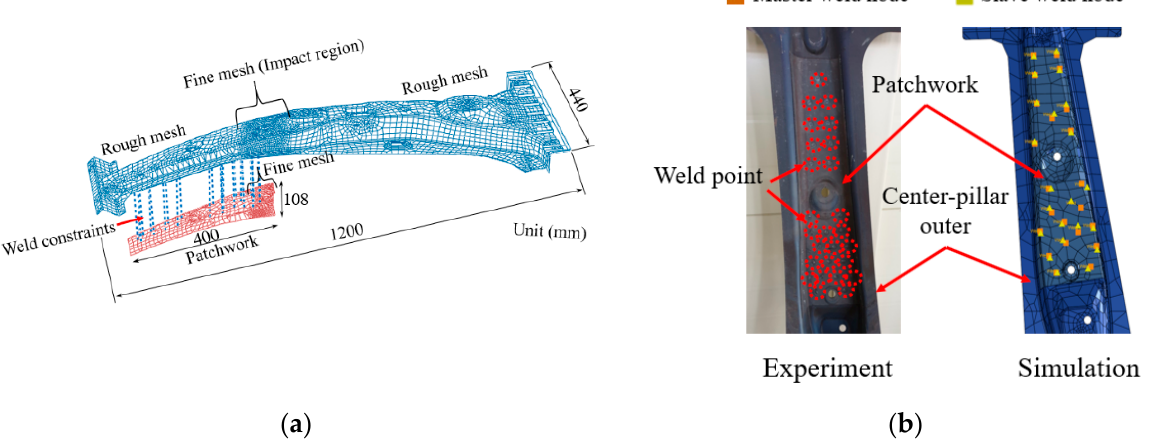
Table 1. Material properties of 22MnB5 (HPF) and 22MnB5 (PS) [20].